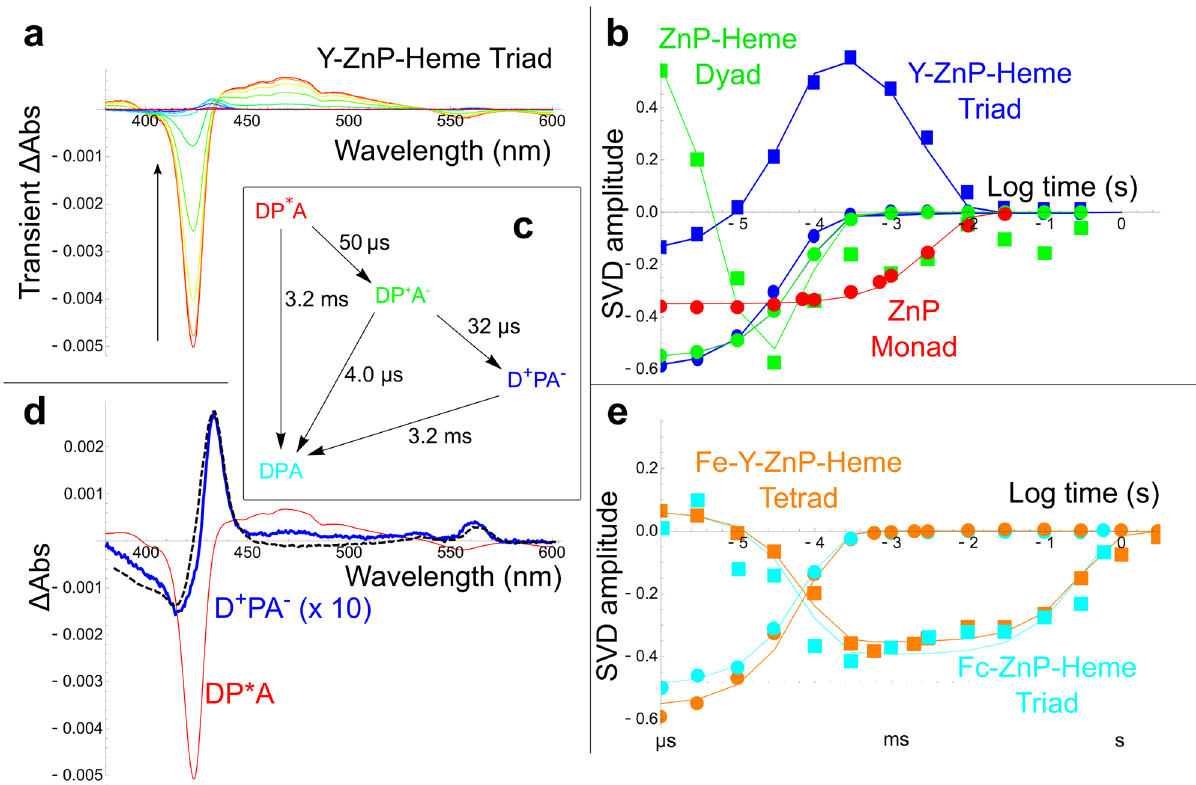
Fig. 3 | Transient spectroscopy of RC maquette reveals the dynamics of light- activatedchargeseparationandrecombination.a DifferencespectraoftheTyr- ZnP-heme triadin L31D/L71H mutant at pH 9.5 are shown for delay times from 1 μ s to 3s after the laser fl ash at log time intervals shown in b . b The fi rst and second principal time varying SVD components of the difference spectra (circles and squares, respectively) fi t to a simple kinetic model connecting DP*A, DP + A − , D + PA − , andDPAstateswithsingleexponential fi rstorderreactions(solidlines):ZnPmonad (red),ZnP-Hemedyad(green),Tyr-ZnP-heme triad(blue),(seealsoSupplementary